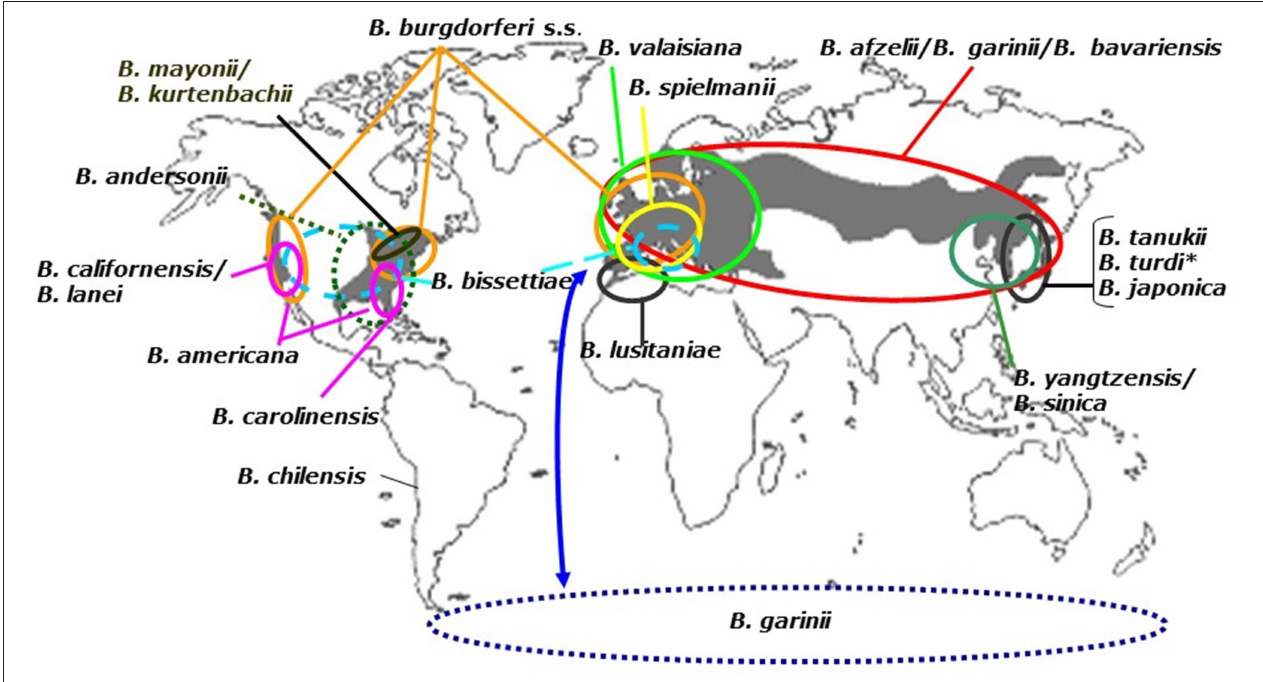
FIGURE 2 | Distribution of Borrelia burgdorferi sensu lato genospecies. To date, 21 Borrelia genospecies have been named and their geographic ranges are shown here. The gray background corresponds to the presence of Ixodes vectors (see above). B. turdi (*), also occurs in Europe. The dotted circle represents the B. garinii transmission cycle that ensues in sea bird colonies in the Southern and Northern hemisphere. The latter is not shown to reasons of clarity.